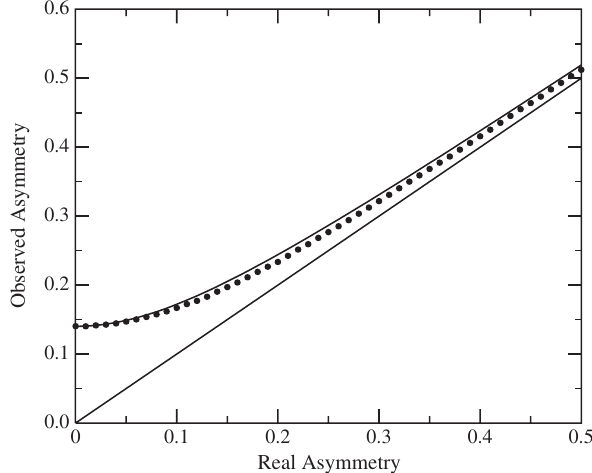
FIG. 10. The dots represent a Monte Carlo estimate of the average observed asymmetry for an analysis based on Eq. (3) with a free magnitude and phase. In addition to the random scatter due to a statistical error on each asymmetry of 0.25, there is a real asymmetry added according to the X-axis value. In the absence of a positive bias, the dots should lie along the straight line where observed and real asymmetries are equal. The curved line represents a hyperbola with the correct end point at zero real asymmetry, but it fails to match the Monte Carlo